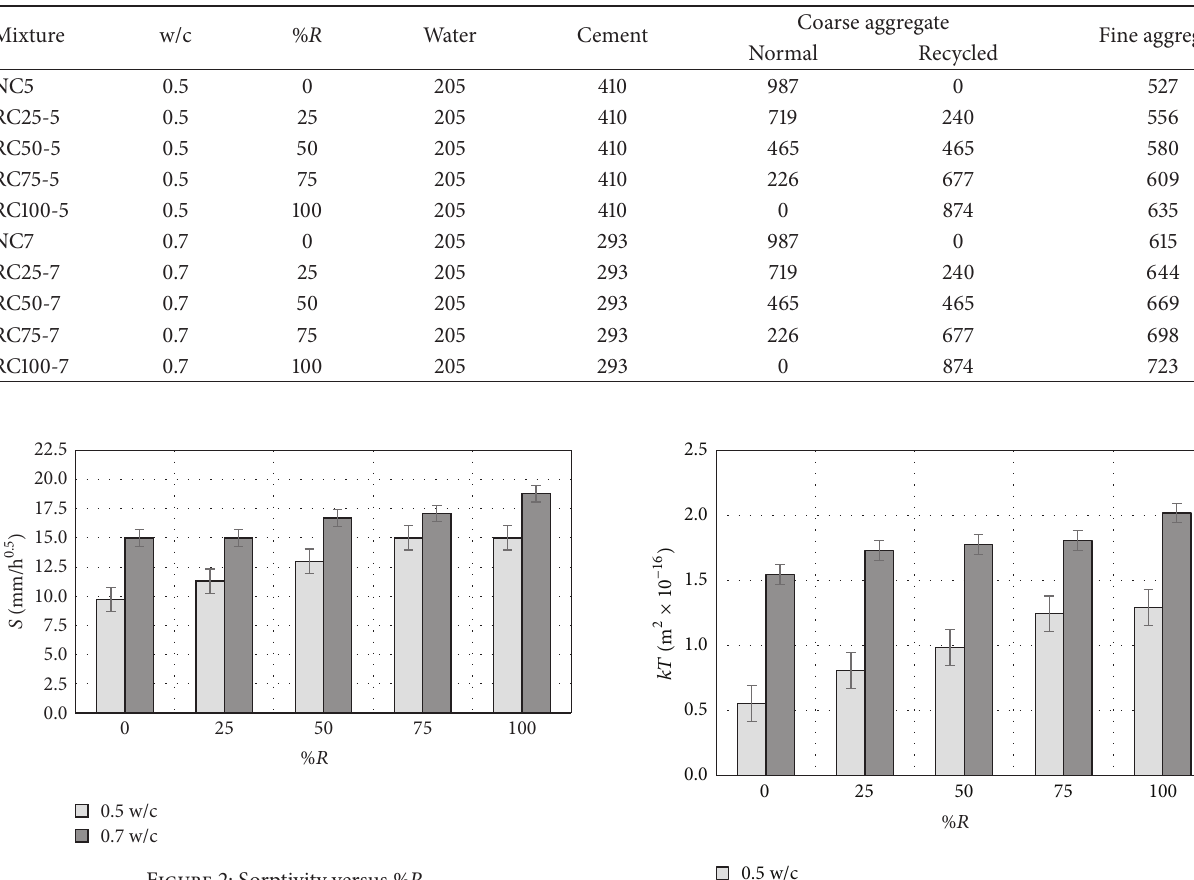
Figure 2: Sorptivity versus % 𝑅 .